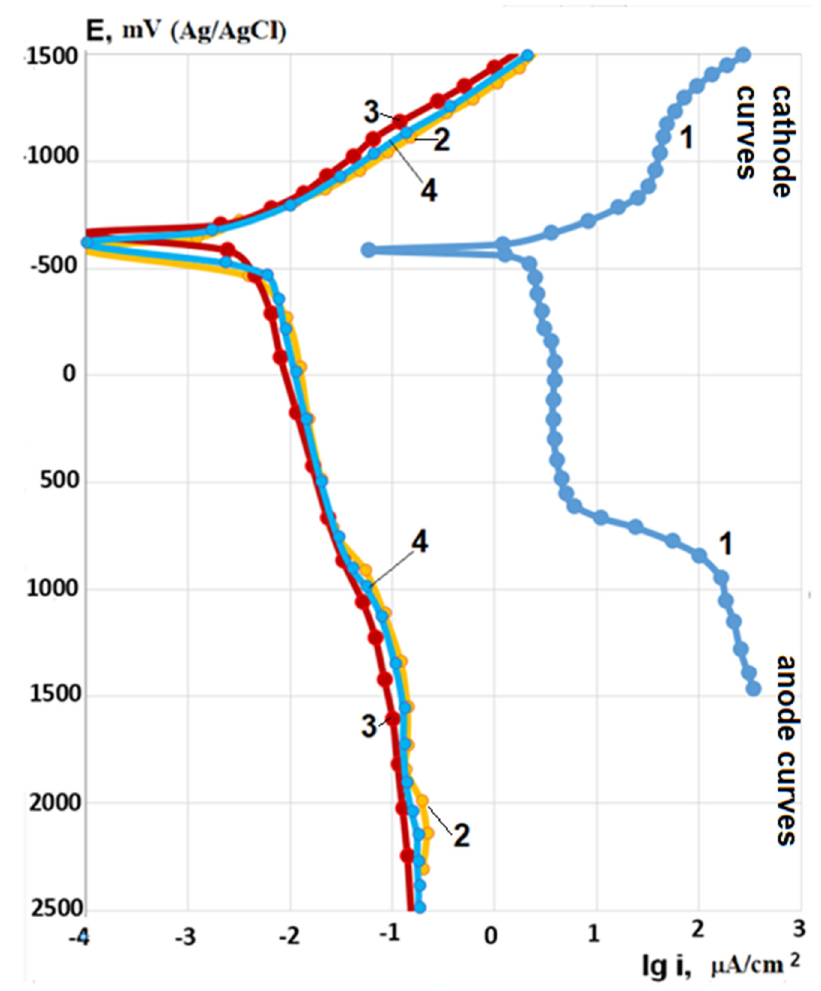
Figure 9. Potentiodynamic polarization curves after 5 min of immersion in corrosive solution 0.5% LiOH at 100 °C for the bare Zr-1Nb alloy (1) and samples with coatings formed at PEO current densities 20 (2), 30 (3), and 40 (4) A/dm 2 .